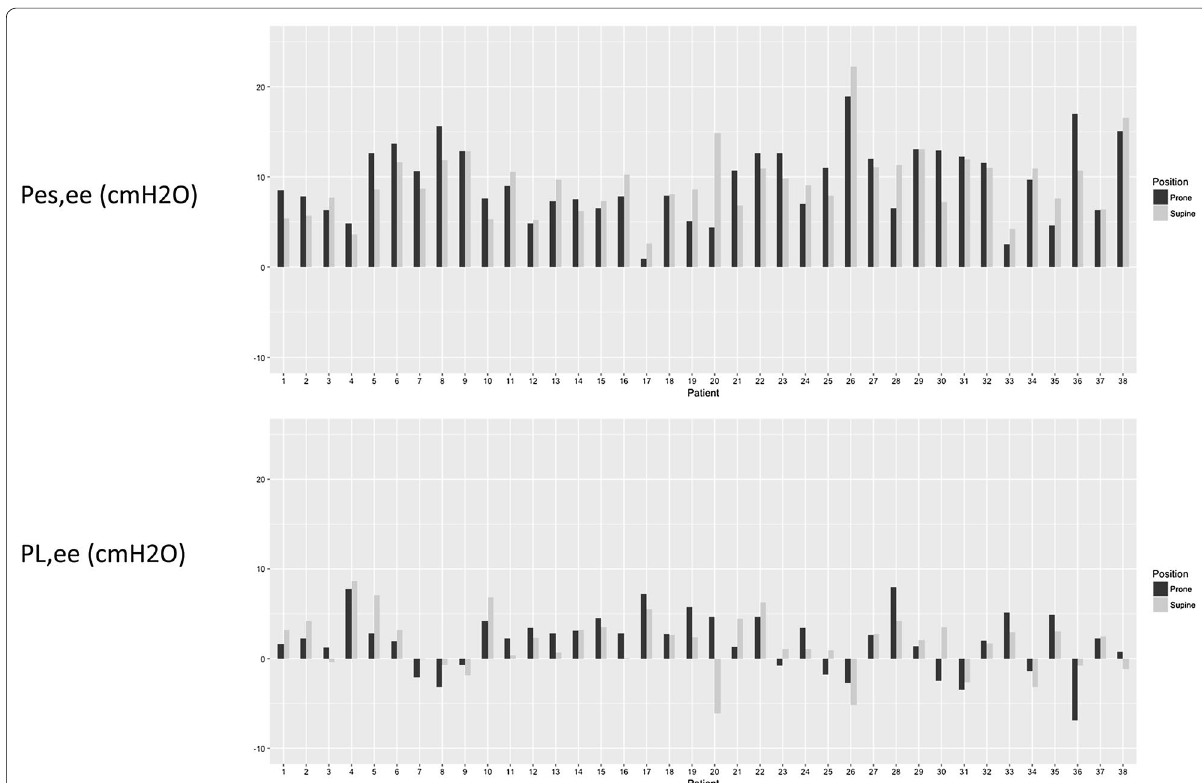
Fig. 1 Individual values of static end‑expiratory esophageal (Pes,ee) (upper panel) and transpulmonary (PL,ee) (lower panel) pressures in supine and prone